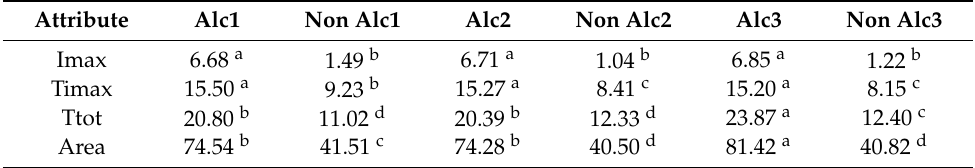
Table 4. Averages of the scores attributed by the time-intensity team to the alcoholic stimulus in alcoholic and non-alcoholic Pilsen beer samples for the evaluated attributes. Attribute Alc1 Non Alc1 Alc2 Non Alc2 Alc3 Non Alc3